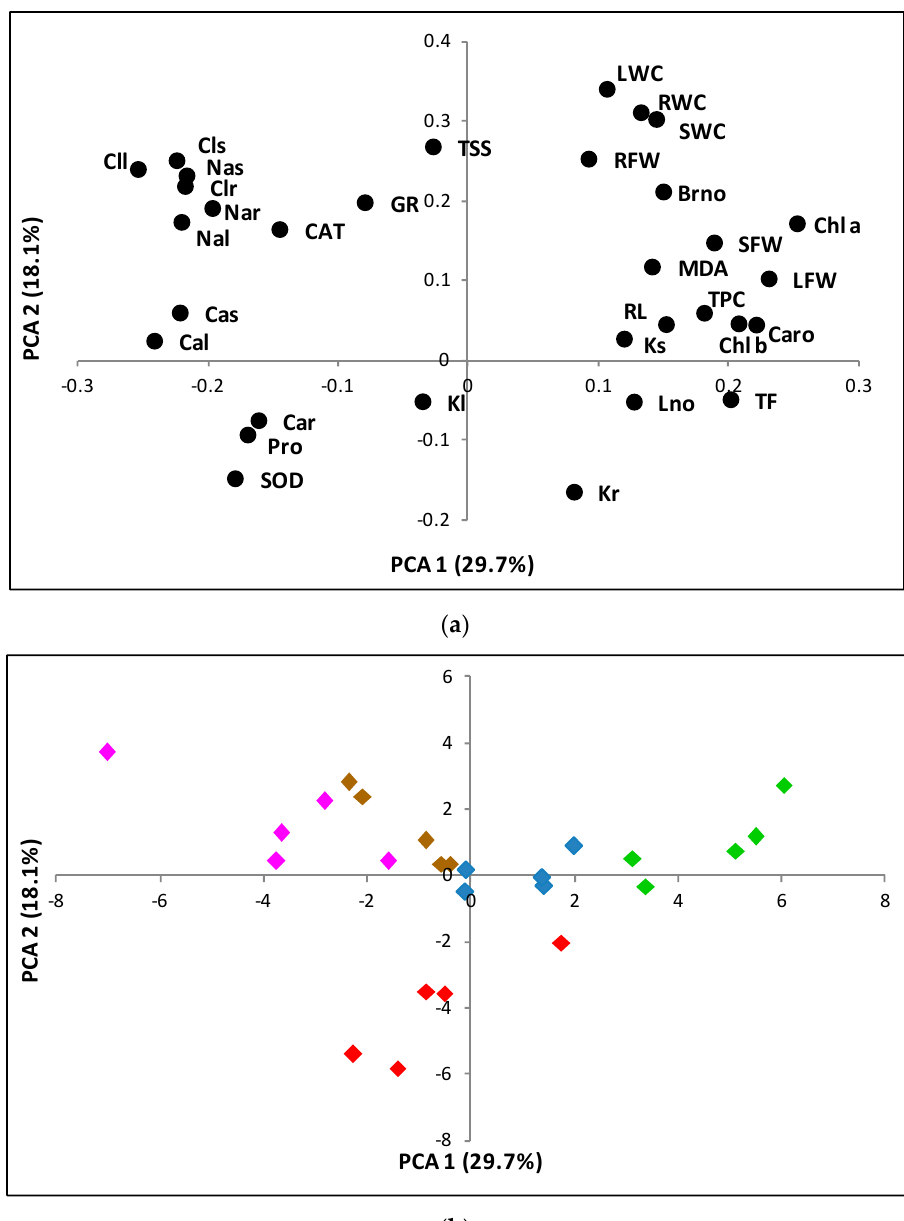
Figure 8. Loading plot ( a ) and scatterplot ( b ) of the principal component analysis (PCA) including all the analysed traits in Thalictrum maritimum plants subjected for 23 days to water deficit and salt treatments. The first (PC1; X-axis) and second (PC2; Y-axis) principal components accounted for 29.7% and 18.1% of the total variation, respectively. Abbreviations in the loading plot ( a ): root length (RL), root fresh weight (RFW), root water content (RWC), stem fresh weight (SFW), stem water content (SWC), branch number increment (Brno), leaf number increment (Lno), leaf fresh weight (LFW), leaf water content (LWC), chlorophyll a (Chla), chlorophyll b (Chlb), carotenoids (Caro), sodium in roots (Nar), sodium in leaves (Nal), potassium in roots (Kr), potassium in leaves (Kl), chloride in roots (Clr), chloride in leaves (Cll), proline (Pro), total soluble sugars (TSS), malondialdehyde (MDA), total phenolic compounds (TPC), total flavonoids (TF), and superoxide dismutase (SOD), catalase (CAT), and glutathione reductase (GR) activities. Symbols in the scatter plot ( b ): control (green), water stress (red), 100 mM NaCl (blue), 200 mM NaCl (brown), and 300 mM NaCl (pink).